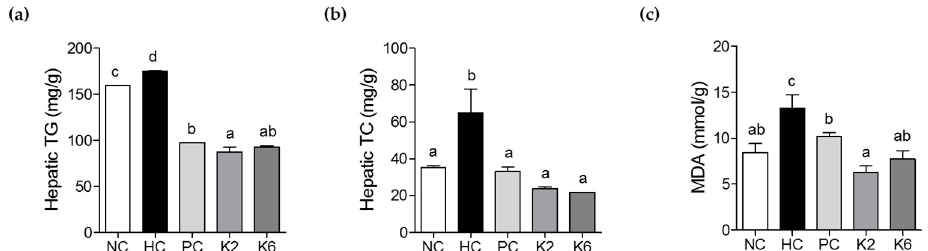
Figure 5. E ff ects of K2 and K6 on hepatic biochemical parameters in the rat model of HF / Figure 5. Effects of K2 and K6 on hepatic biochemical parameters in the rat model of HF/HF-induced NAFLD. ( a ) Hepatic TG, ( b ) TC, and ( c ) MDA levels. NC, normal diet control; HC, HF/HF diet control;